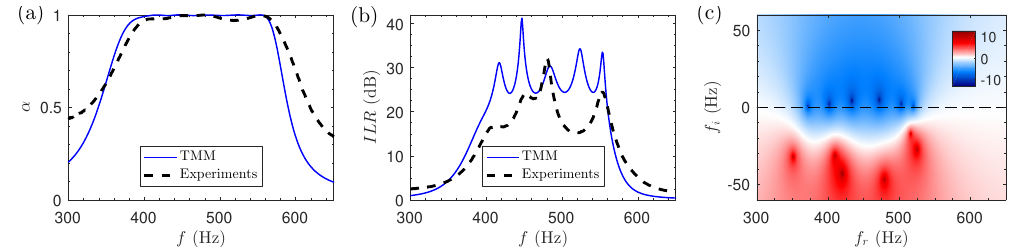
Figure 5. Impedance tube results: 1D system. Theoretical and experimental ( a ) absorption coefficient and ( b ) Insertion Loss in Reflection (ILR), along the optimized range of frequencies. ( c ) Reflection coefficient along the complex frequency plane for the optimized